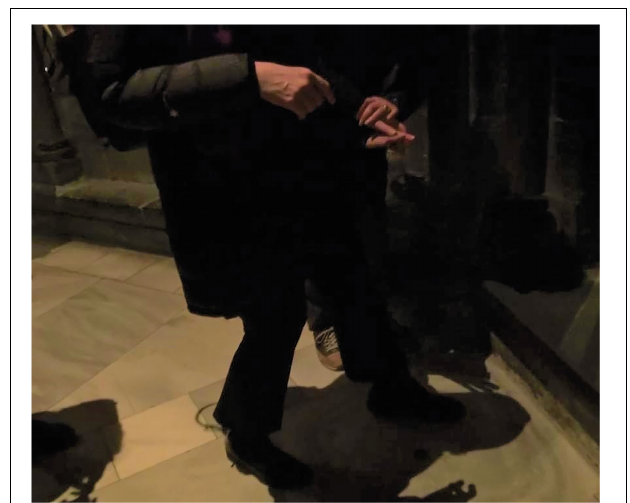
FIGURE 6 | Perception with left